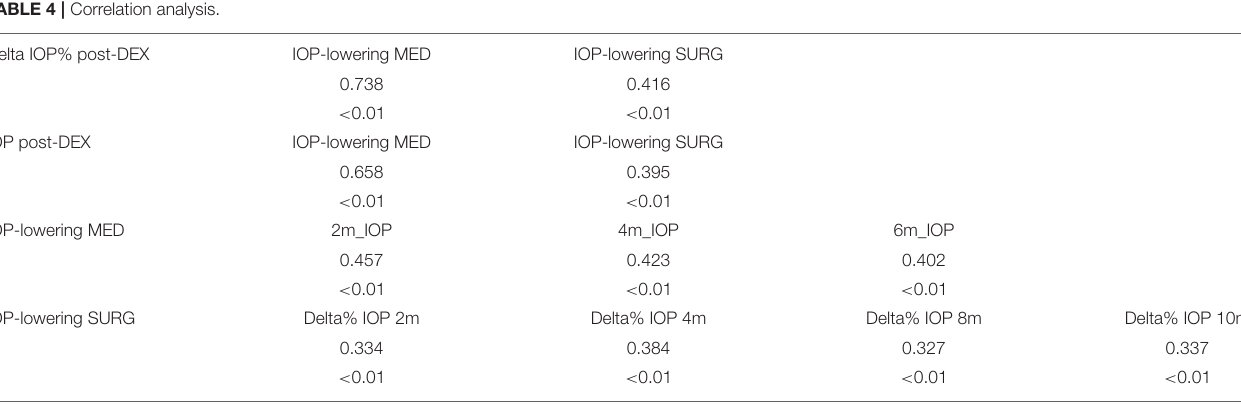
TABLE 4 | Correlation